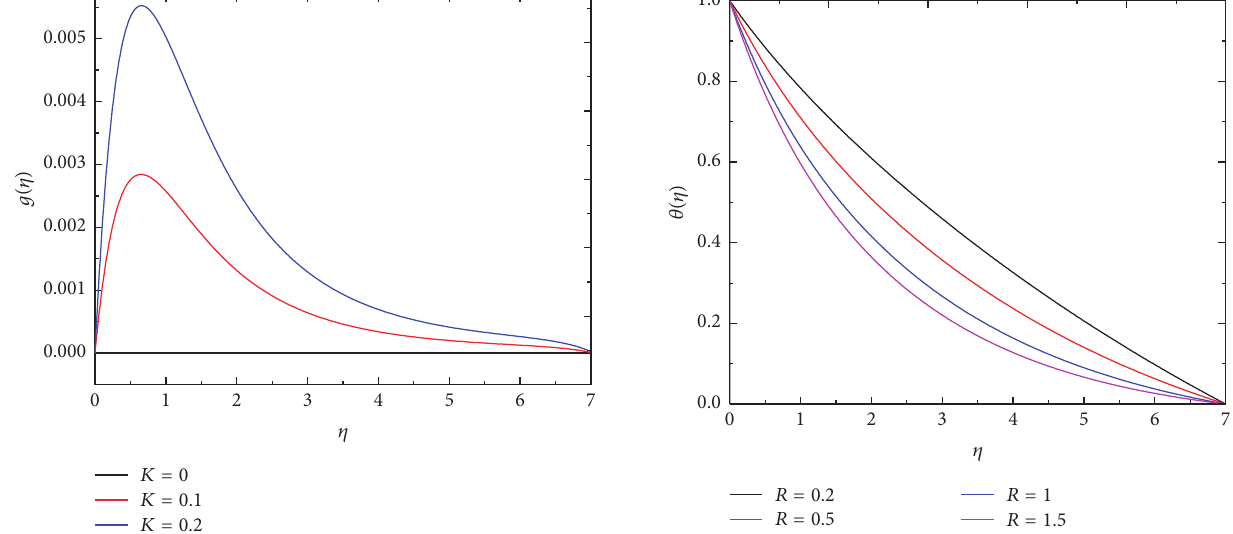
Figure8:Temperatureprofilesforvariousvaluesof 𝑅 when 𝐾 = 0.2 , 𝐴 = 0 , and 𝜉 = 0 .